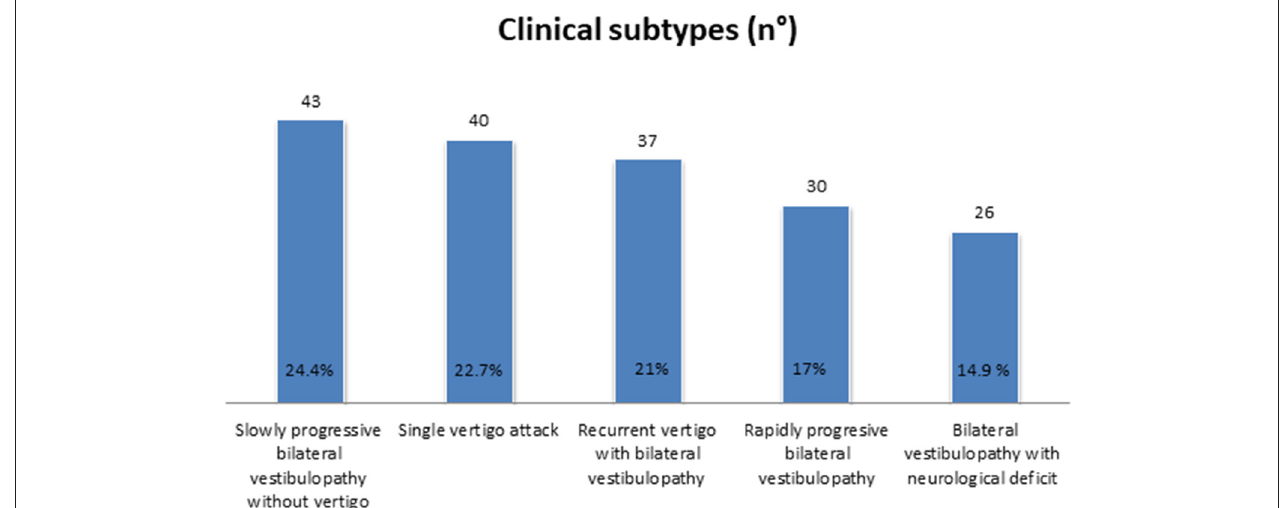
FIGURE 2 | Clinical subtypes.